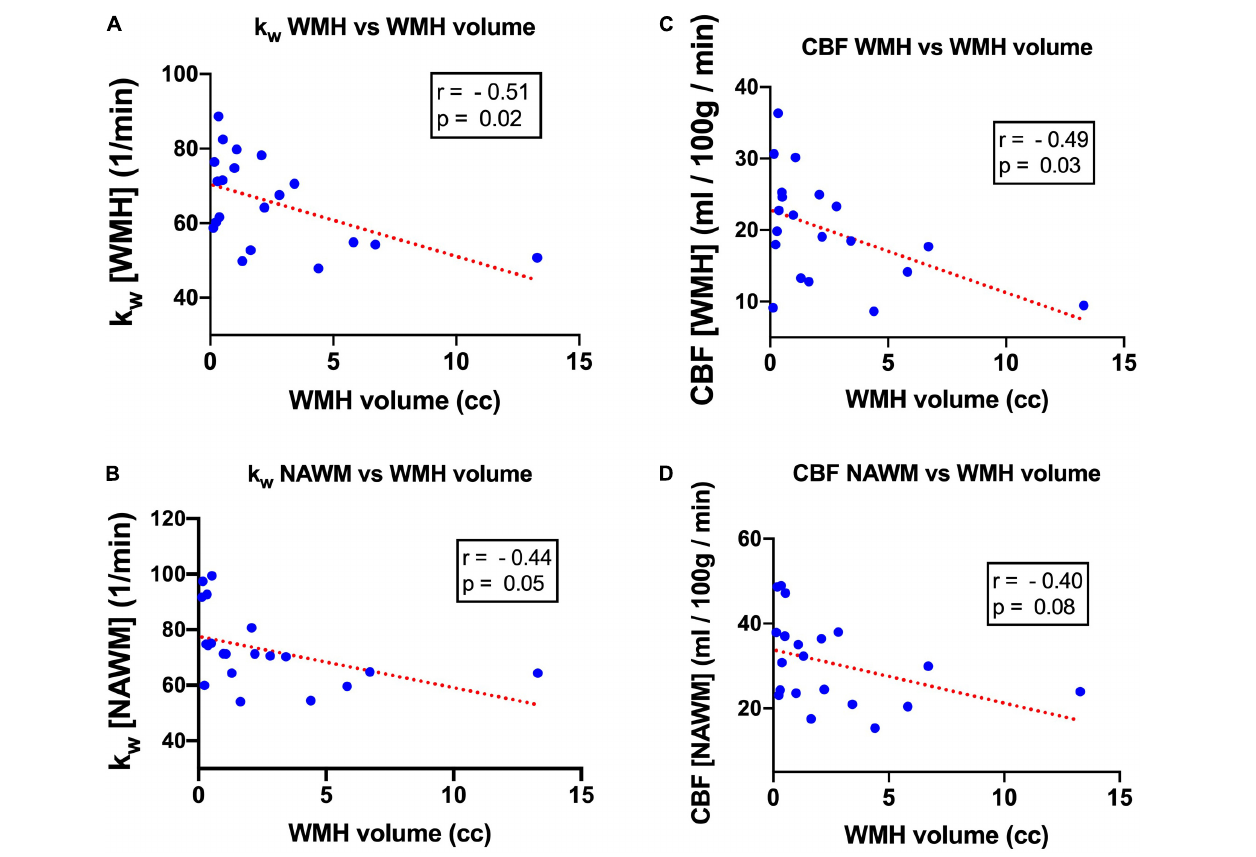
FIGURE 5 | Scatterplot and linear regression line characterizing the relationship between k W and WMH volume in (A) WMH and (B) NAWM, as well as the relationship between CBF and WMH volume in (C) WMH and (D)